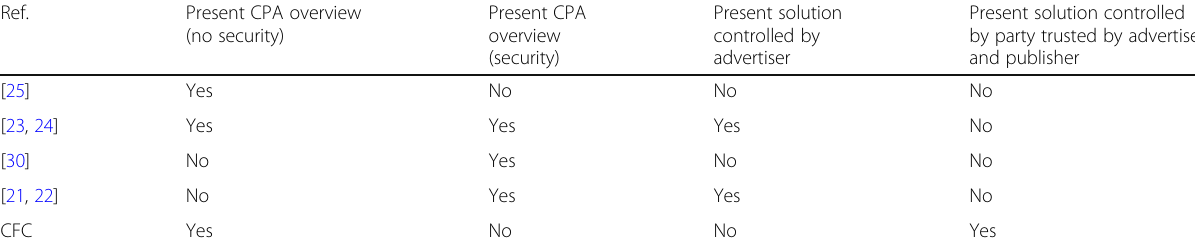
Table 2 CPA literature vs our work